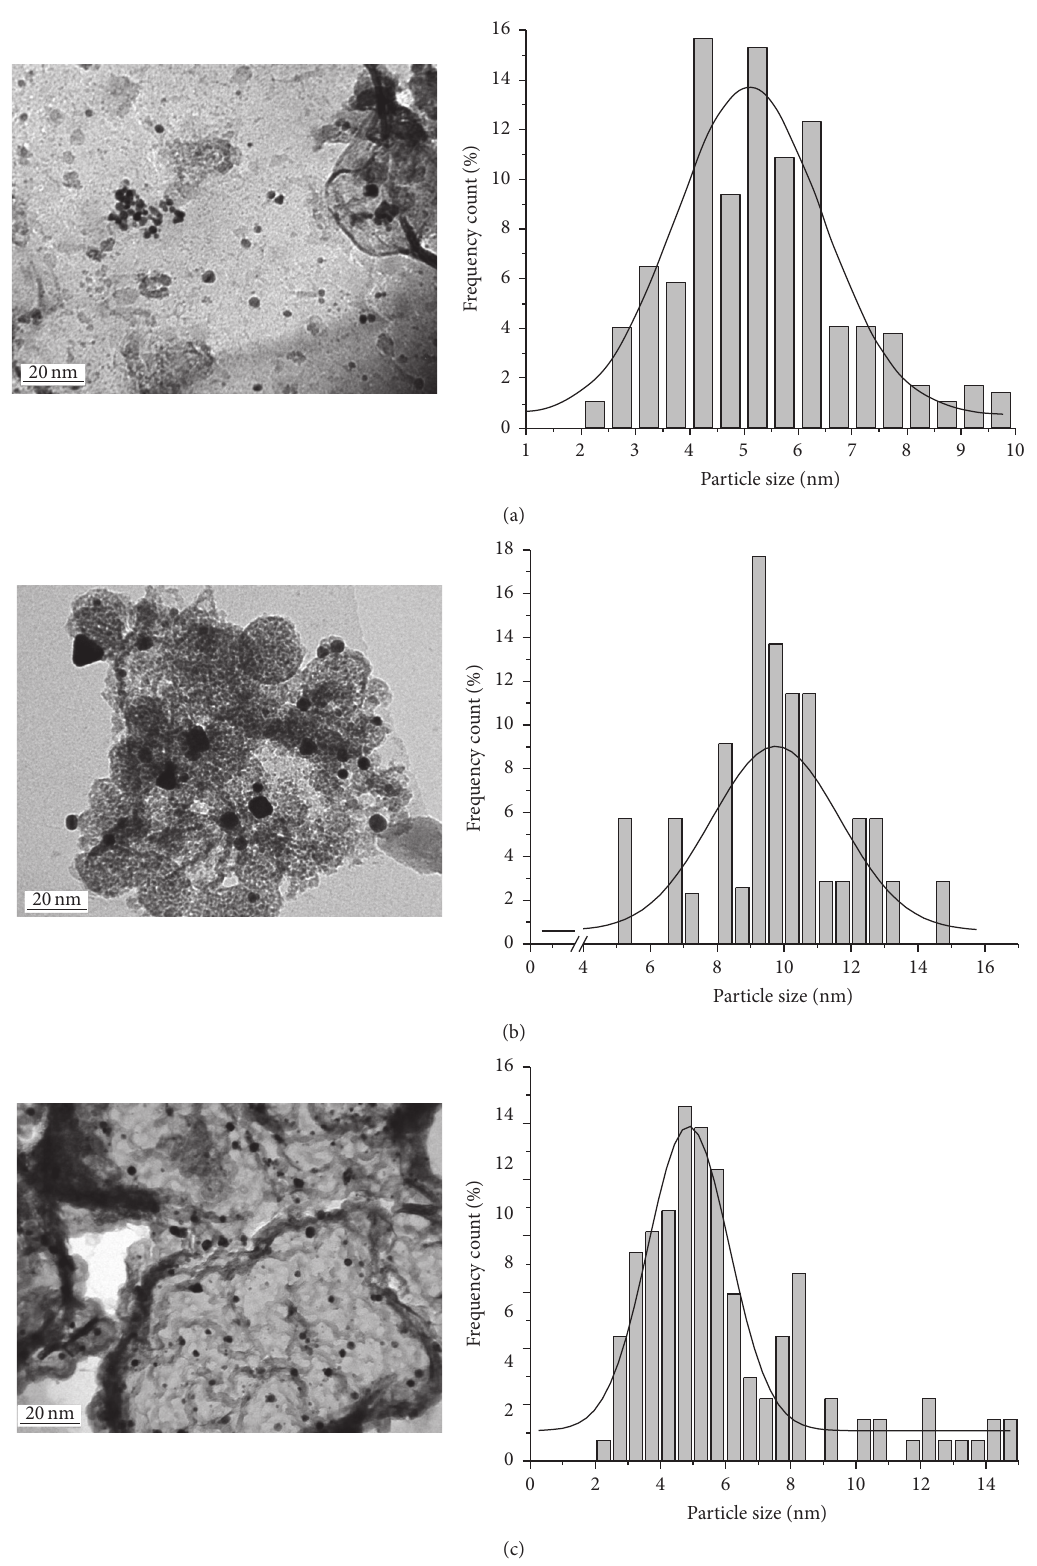
Figure 2: Representative TEM Micrograph and Au nanoparticle size distribution measurements for Au/P[VBTACl]/M catalysts. (a) M: Al; (b) M: Ti; (c) M: